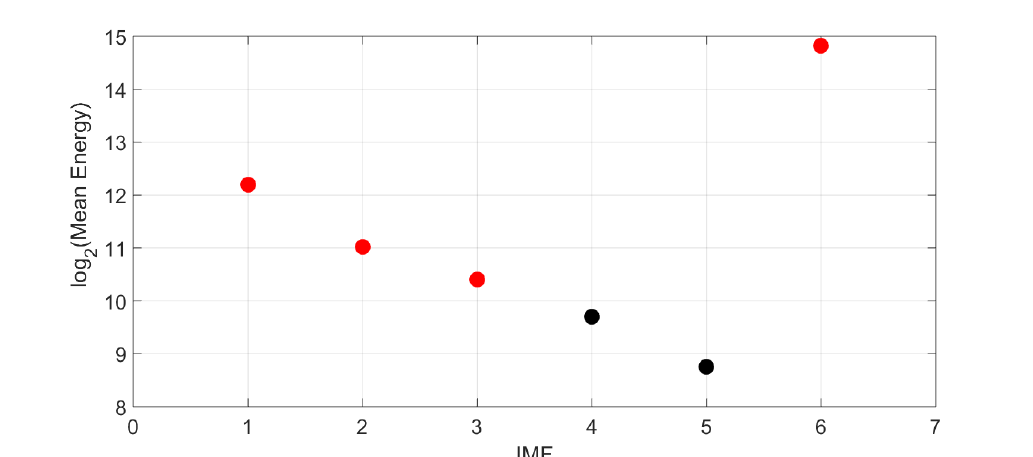
Figure 6. The energy density of IMFs component of average monthly precipitation time series during 2003-2016 in Caspian catchment